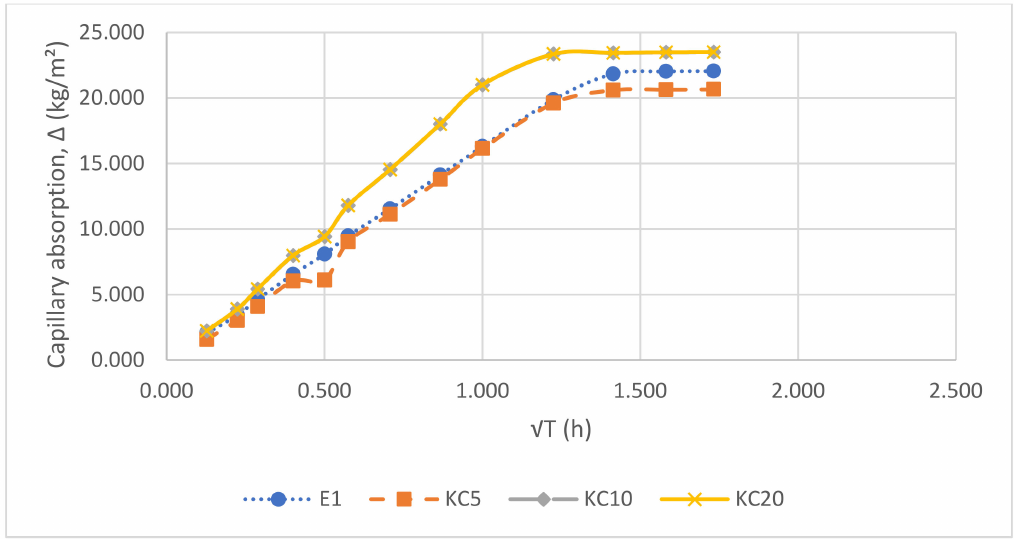
Figure 11. Capillary water absorption in Series 2 (varied w/b ratio and percentage of